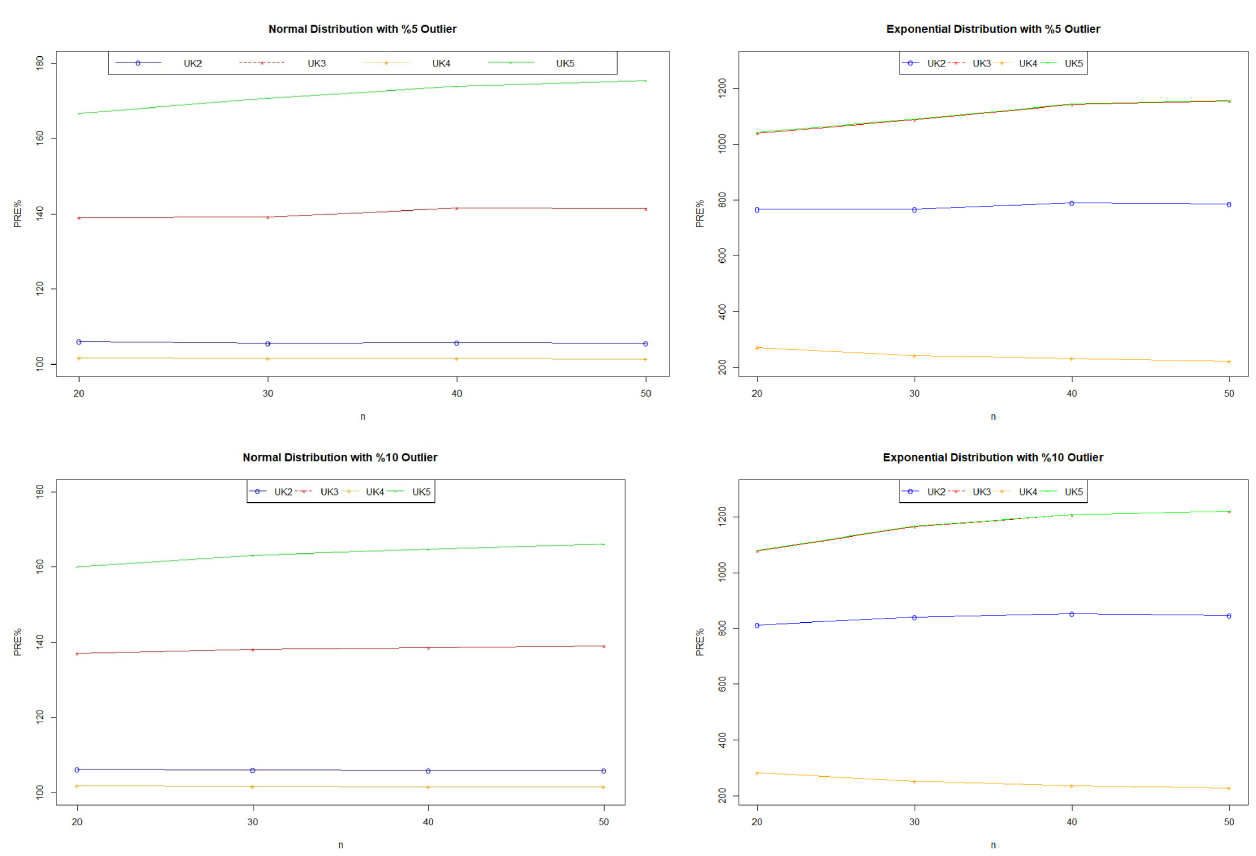
Fig 5. PREs of the proposed estimator against y